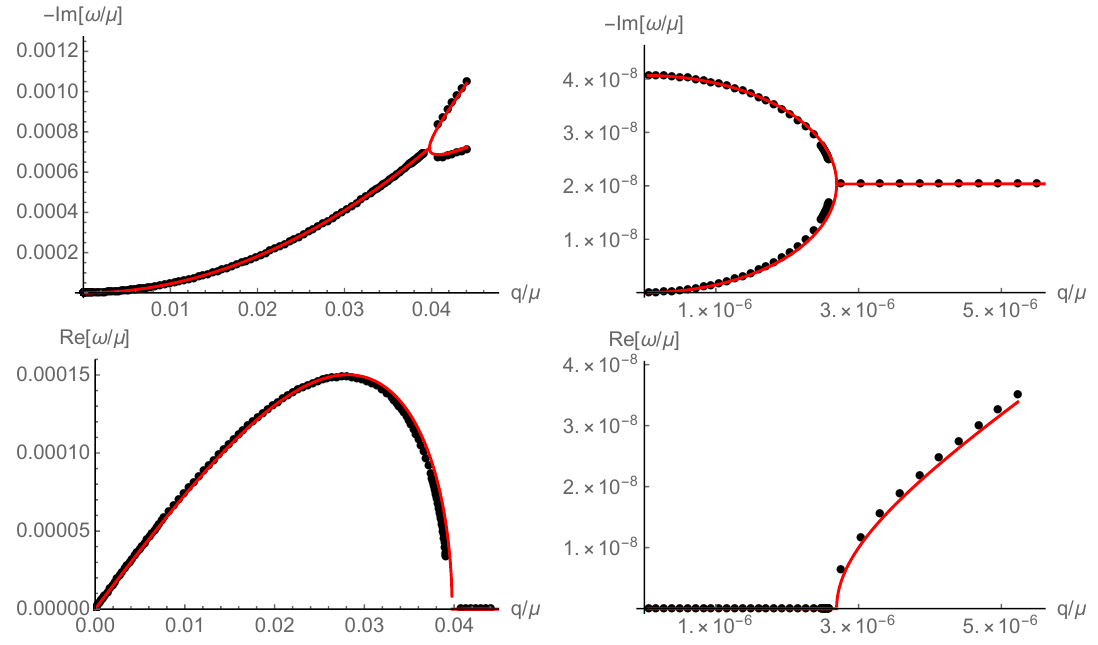
Figure 3 . Comparison of the hydrodynamic dispersion relation (3.6) (red lines) to the numeri- cal results (black dots) for large q (left panels) and small q (right panels), at ( ‘=(cid:22); k=(cid:22); T=(cid:22) ) = (10 (cid:0) 4 ; 10 (cid:0) 2 ; 10 (cid:0) 1